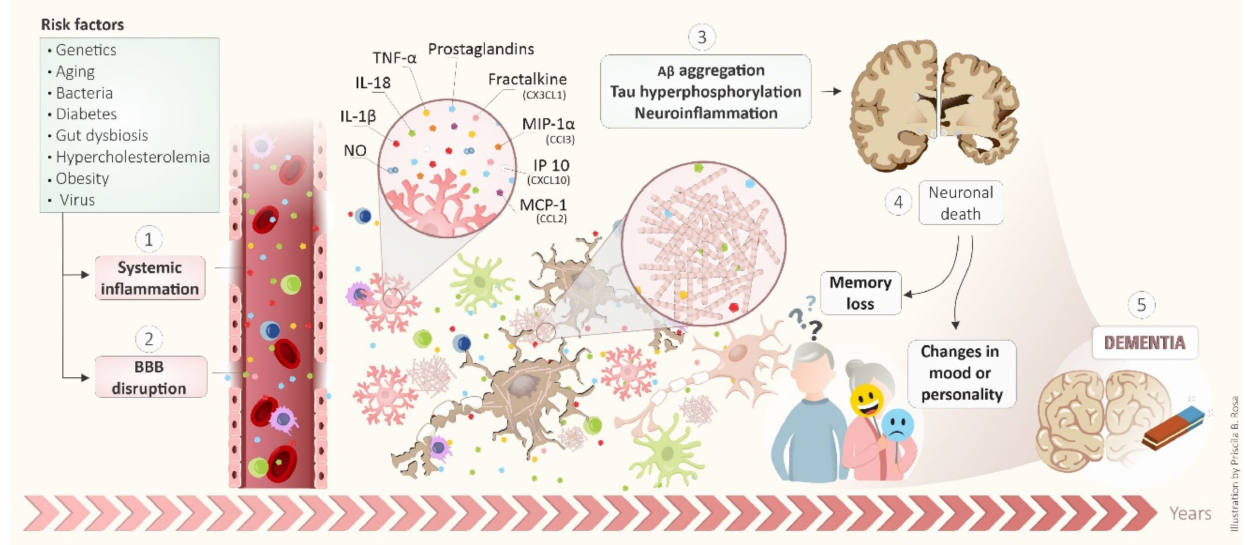
Figure 4. Schematic integrated view of mechanisms involved in development and progression of